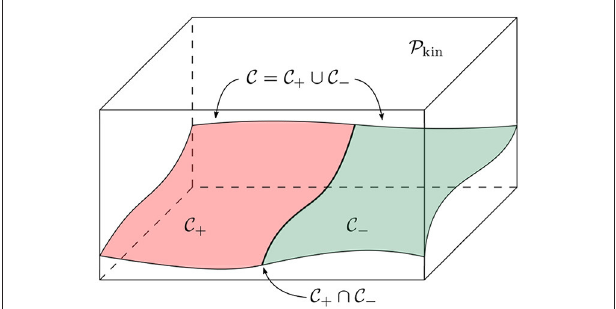
FIGURE 1 | Depicted are the surfaces C C 0 and C 0, respectively. The union of these surfaces is the constraint + = − = C C P kin , while their intersection C surface C = + ∪ − ⊂ H S by p t 0, and is depicted by the thick black line. We have assumed that = = H S is not degenerate (see Figure 1 of [ 31] for a similar depiction when H S is doubly